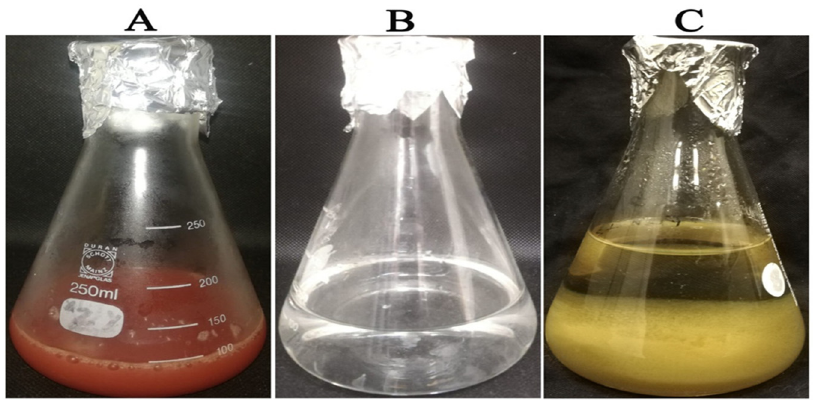
Figure 1. Synthesis of zinc oxide nanoparticles utilizing Punica granatum peel extract. ( A ) pomegranate peel aqueous extract; ( B ) colorless zinc nitrate hexahydrate solution; ( C ): dark-yellow precipitate formation indicating synthesis of ZnO NPs.